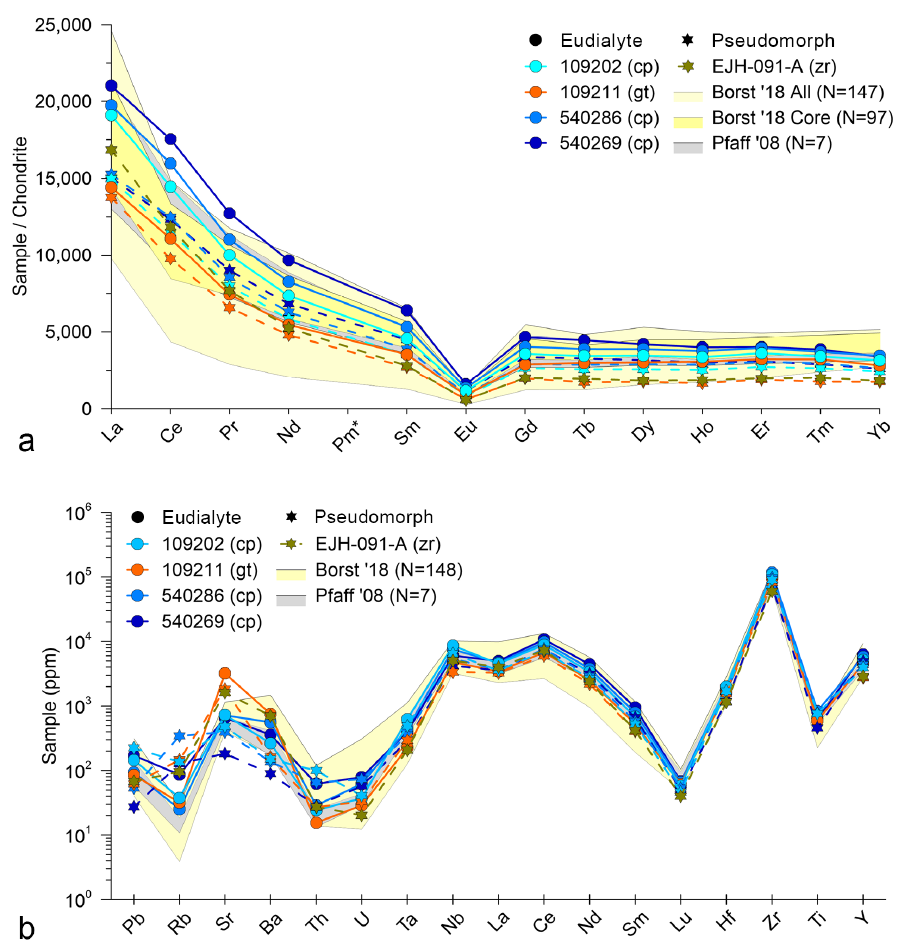
Figure 4. ( a ) chondrite-normalised rare earth element concentrations for eudialyte and pseudomorphs plotted against eudialyte data from Borst et al. [16] (Electron Microprobe, one analysis excluded) and Pfaff et al. [50] (Laser Ablation ICPMS). Concentrations measured from eudialyte cores by Borst et al. are plotted separately—normalisation against CI Chondrite [49]; ( b ) selected major and trace elements as determined by ICPMS, plotted against literature data for eudialyte; sources as for ( a ). cp = catapleiite-type, gt = gittinsite-type, zr = zircon-type alteration